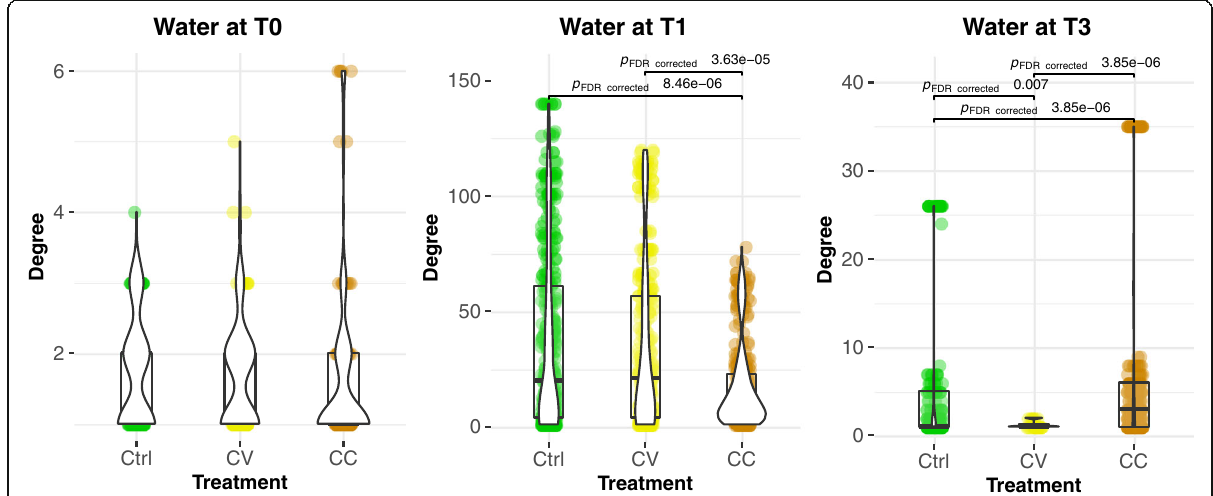
Fig. 5 The average degree of water microbial networks over time and between treatments. The connectivity represented with violin plots is significantly higher on average for the control groups in the gut and the skin at times T3 and T1. The average of nodes ’ degree computed with Network Analyzer was compared using the Kruskal-Wallis test followed by Benjamini-Hochberg test. The value of 0.05 is the threshold of B-H p - value significance. Only the significant Dunn test p -values for pairwise comparisons are displayed on this figure, however in order to improve visibility, the significant p -values of Kruskal-wallis test for multiple groups comparisons were not